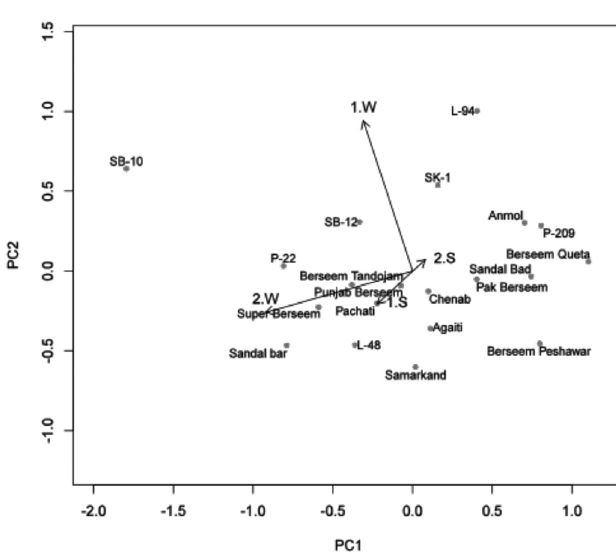
Fig. 2: GGE biplot of dry biomass in the first (1) or second (2) cut under water restriction (S) andfull irrigation (W) for twenty ecotypes of berseem clover ( Trifolium alexandrinum L.).